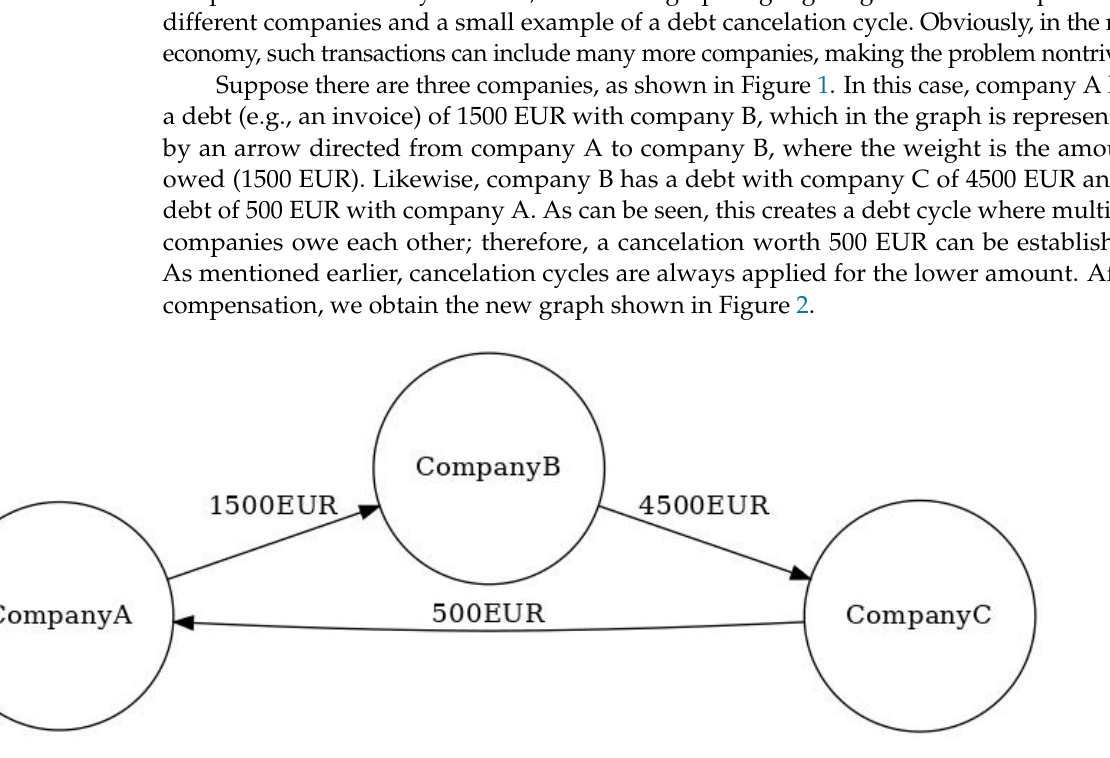
Figure 1. Debt relation among three companies.